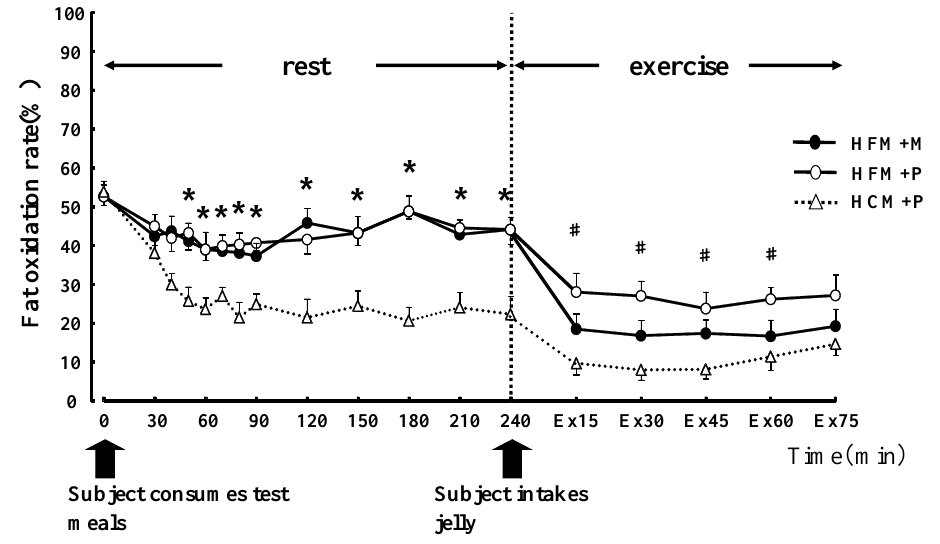
* indicates when high-fat meal with maltodextrin (HFM + M) and high-fat meal with placebo (HFM + P) values were significantly higher than high-carbohydrate meal and placebo (HCM + P) values ( p < 0.05). # indicates when HFM + P was significantly higher than HCM + P ( p < 0.05). Data are shown as mean ±